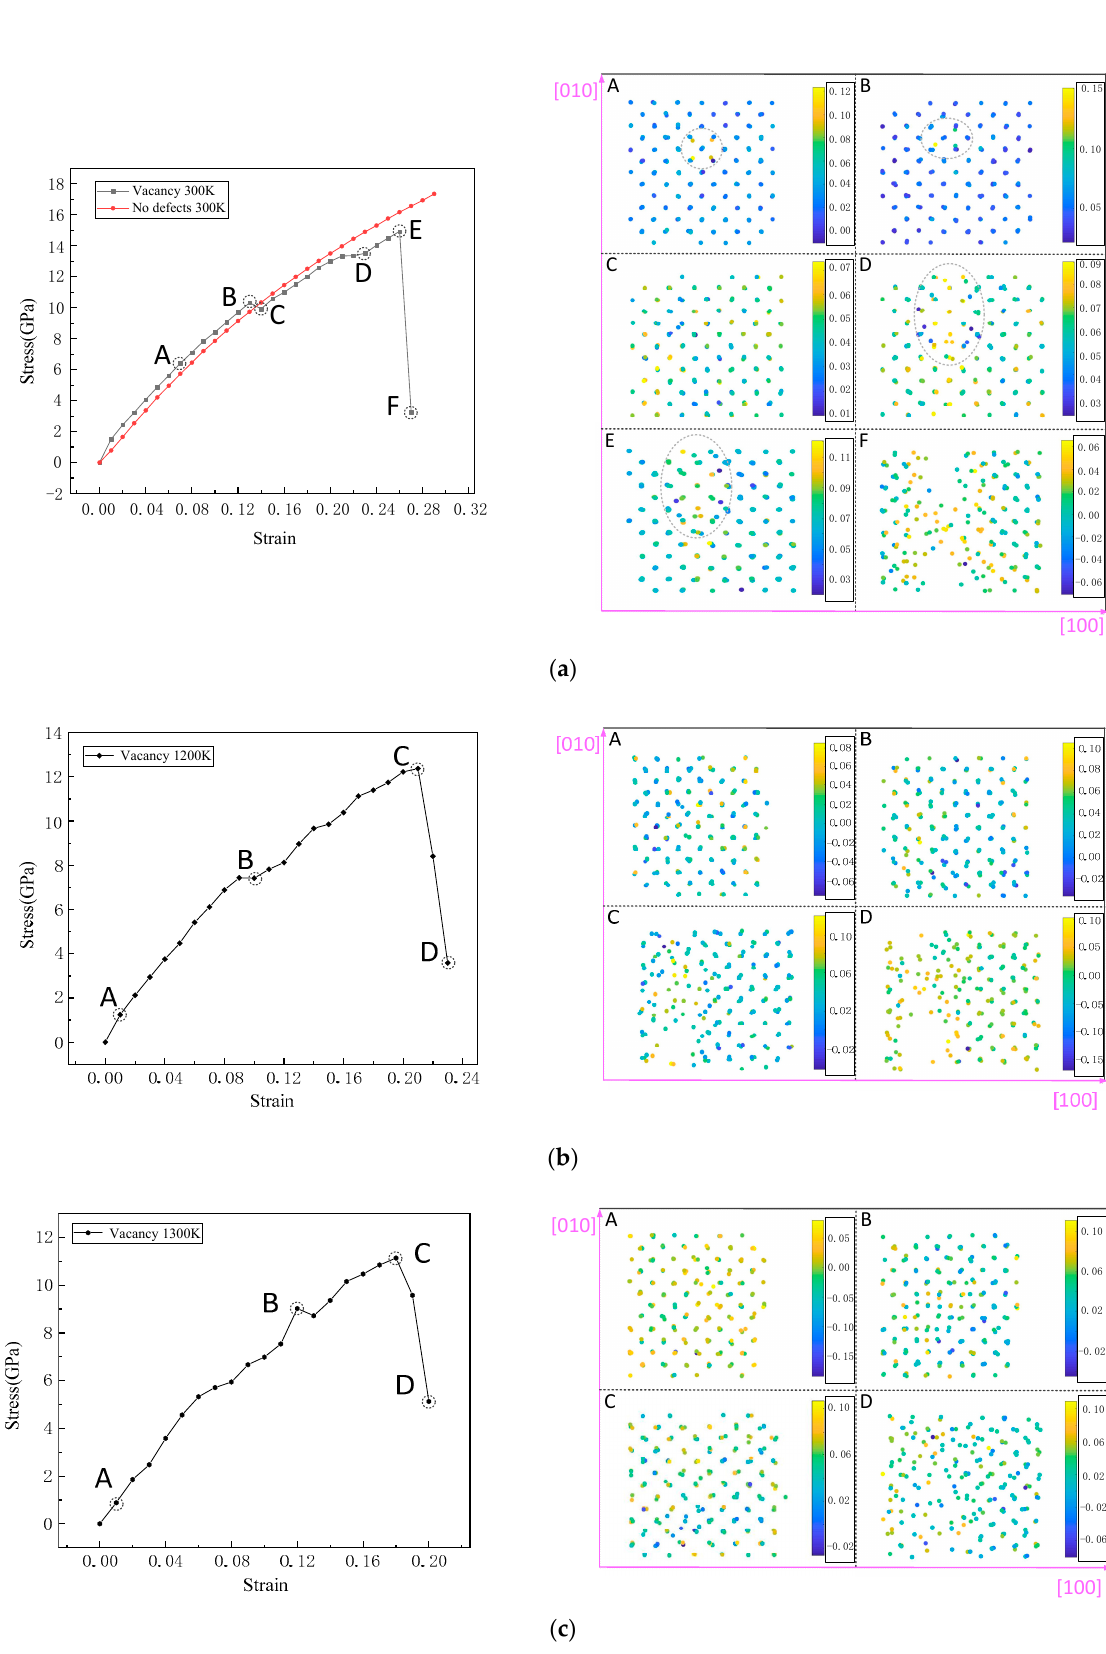
Figure 5. Stress varying with the strain and pressure distribution of ( a ) the prefect Si lattice and the Si lattice with one vacancy at 300 K, ( b ) the Si lattice with one vacancy at 1200 and ( c ) 1300 K along the [100] axis. The pictures on the right shows the packing structures corresponding to the letters at different strains on the